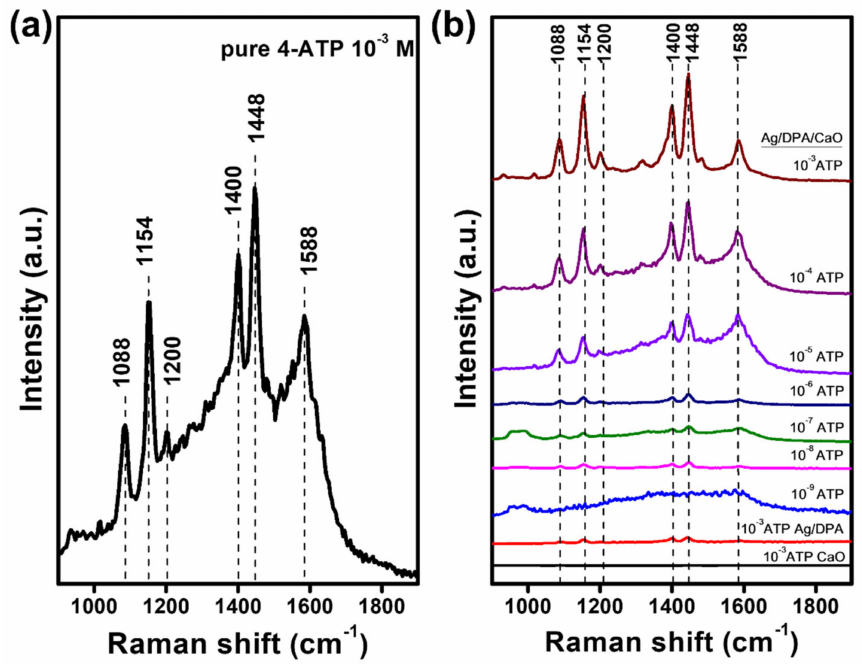
Figure 4. ( a ) Raman spectra of pure 4-ATP 10 − 2 M. ( b ) SERS spectra as a function of 4-ATP concen- tration while being adsorbed on Ag/PDA/CaO-4h